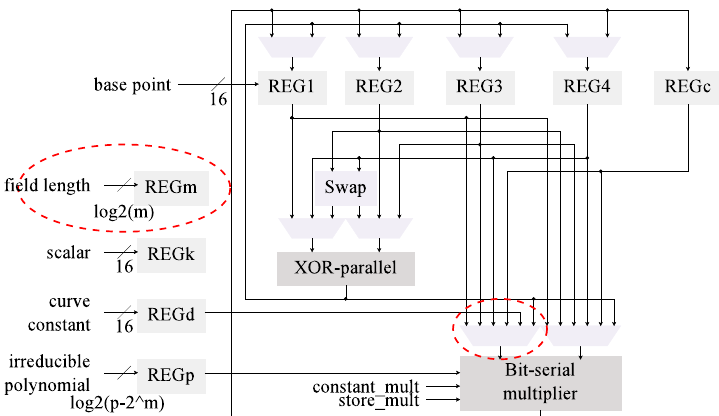
Figure 2. Architecture for kP featuring Itoh-Tsujii inversion (C1).